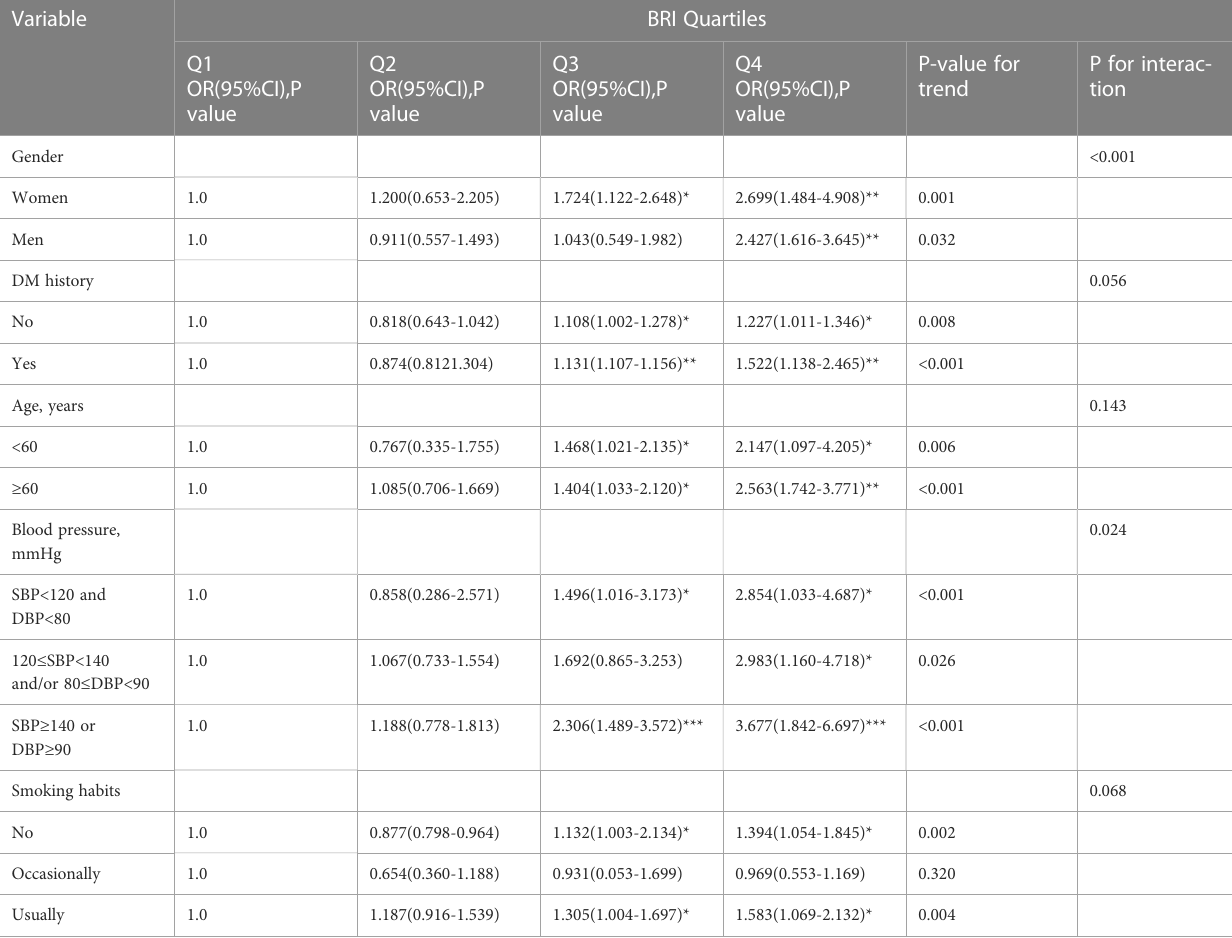
TABLE 3 Association between BRI quartiles and eGFR in different